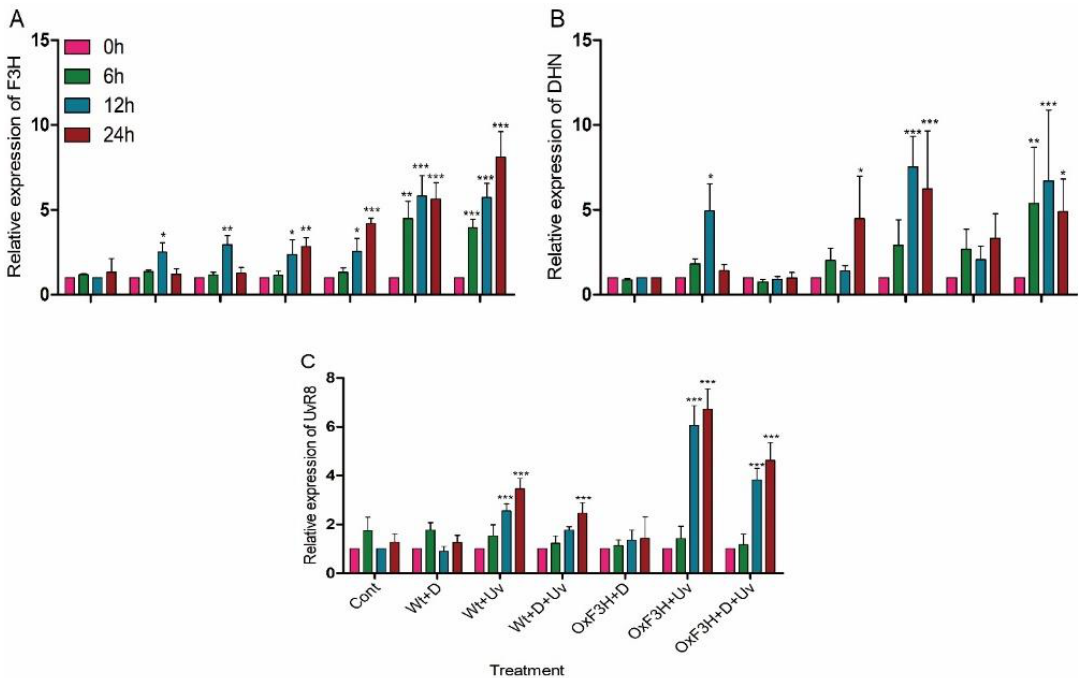
Figure 4. Regulation of F3H, DHN. and UVR8 gene expression under drought and UV-B radiation stress in wild and transgenic rice plants. ( A – C ) The relative expression of F3H, DHN, and UVR8 genes, respectively. The fold change of each gene was measured after 0 h, 6 h, 12 h, and 24 h intervals via qPCR using Actin as a reference gene. Graph bars indicate mean ± standard deviation and asterisks show a significant difference (* p ≤ 0.05, ** p ≤ 0.01, *** p ≤ 0.001) analyzed by two-way ANOVA with Bonferroni correction.